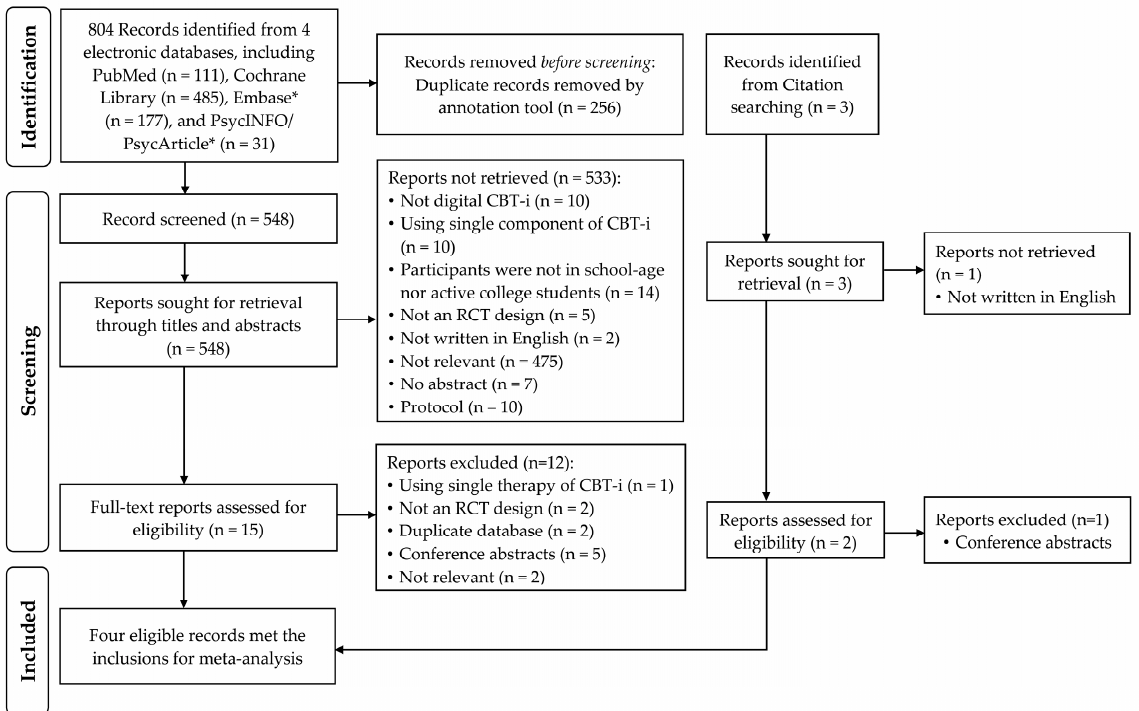
Figure 1. PRISMA study inclusion flowchart. Studies published between January 1991 to October 2021 were collected from four key electronic databases. CBT-i, cognitive behavioral therapy for insomnia; RCT, randomized controlled trial. *, Search duration was set from January 1991 to April 2020.